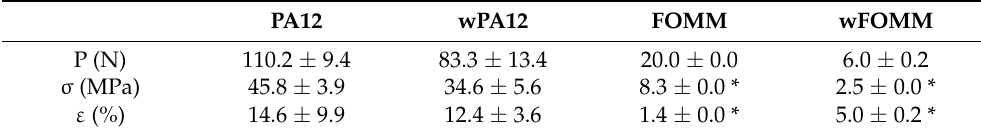
Table 3. Tensile strength results of PA12, wPA12, FOMM, and wFOMM